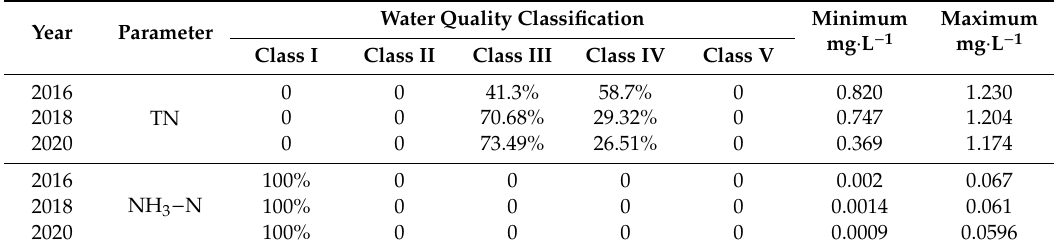
Table 3. Changes of TN and NH 3 -N concentrations during the study period.